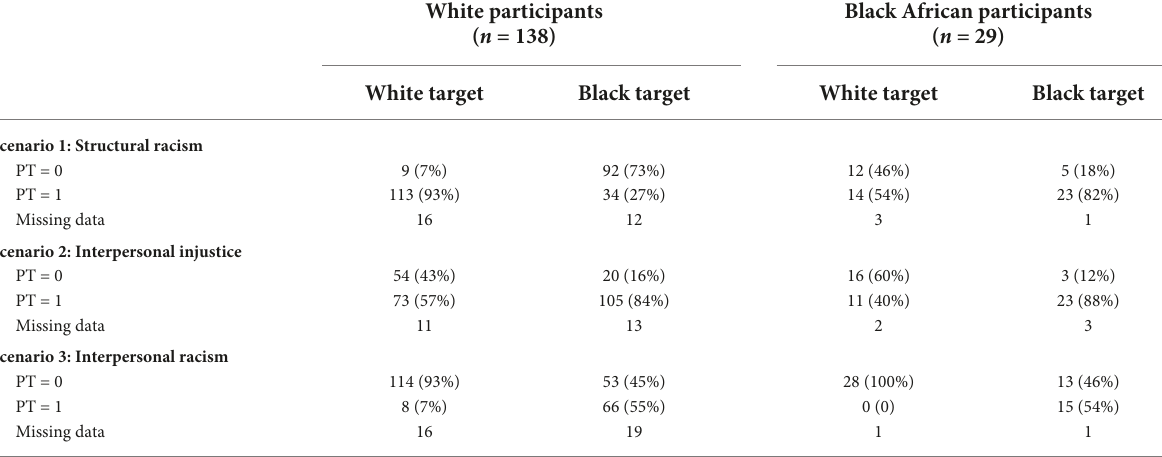
Datapresentedarefrequencieswithpercentagevaluesinbrackets.Missingdataincludeunansweredquestionsandresponseswherethepresence/absenceofperspectivetakingwasunclear.